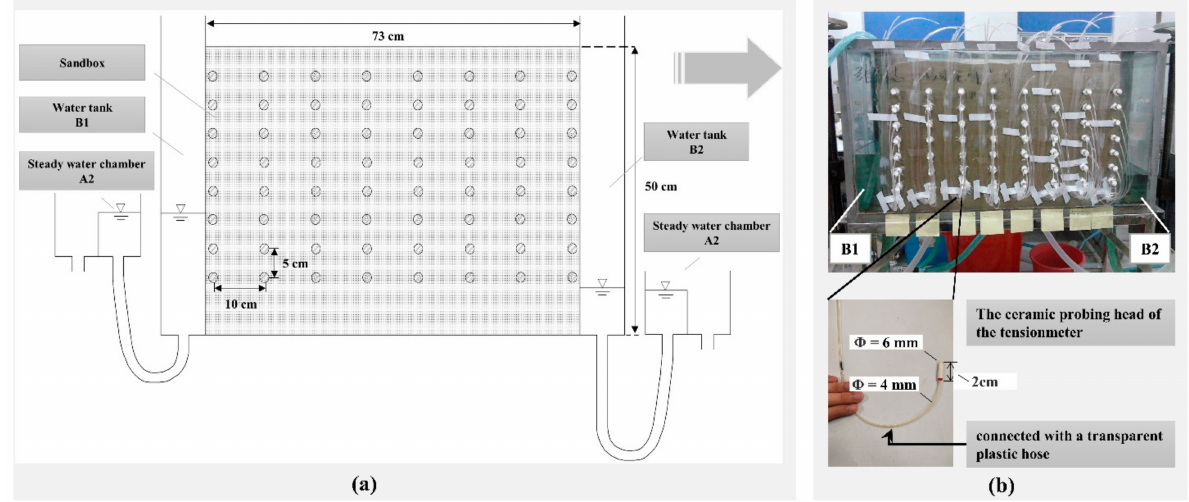
Figure 2. ( a ) The experimental apparatus for physical simulation; ( b ) object diagram of the experimental apparatus for physical